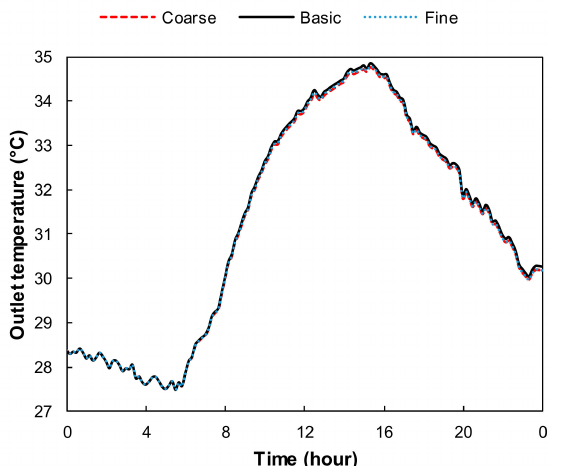
Figure 6. The CFD predicted outlet temperature of the EAHE during the day using the coarse, basic, and fine girds.